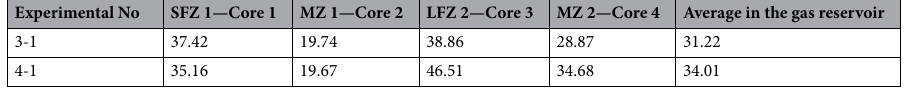
Table 13. Water saturation increment (%) in different zones at the ends of Experiments 3-1 and 4-1.